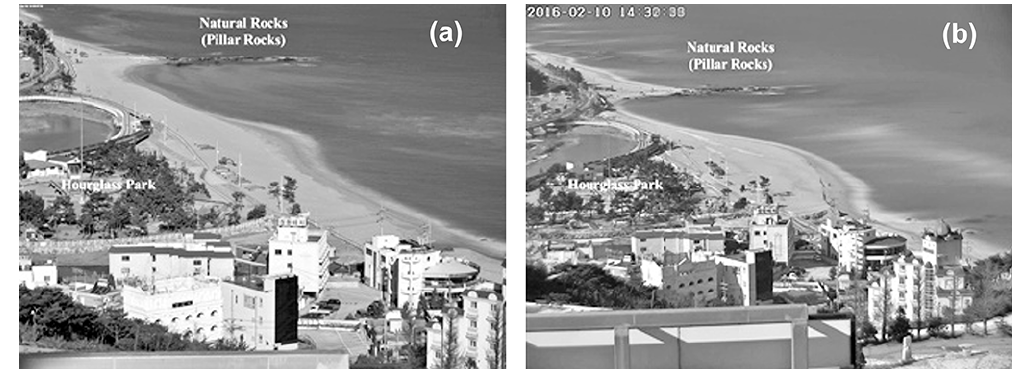
Figure 2. Beach erosion at Jeongdongjin Beach, South Korea caused by (a) low waves on 4 December 2015 and (b) high waves on 10 Febru- ary